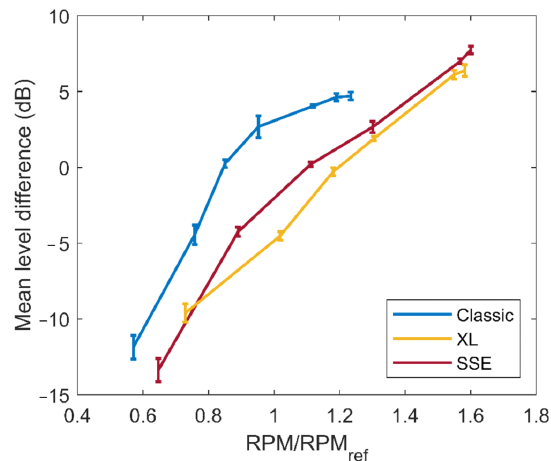
Figure 4. Relation between the sound power and the normalized RPM, as introduced in the source model, for the three multicopters under evaluation. The error bars (standard deviation) show the variation for all considered radiation angles.